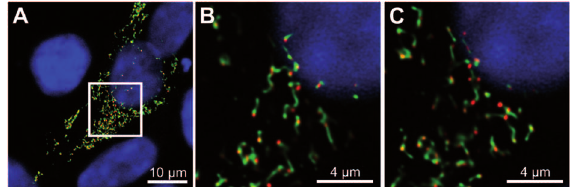
Figure 2 Pex11 induces peroxisome elongation. (A) Maximum intensity projection of a confocal microscopic image showing the effect of ectopic expression of EGFP–HsPEX11 b (green channel) on peroxisomes in human embryonic kidney cells (HEK293T). The elongated peroxisomal membrane shows segre- gation of the matrix marker, mCherry–Px (red channel). (B, C) Sin- gle z-layers from the insert region indicated in panel